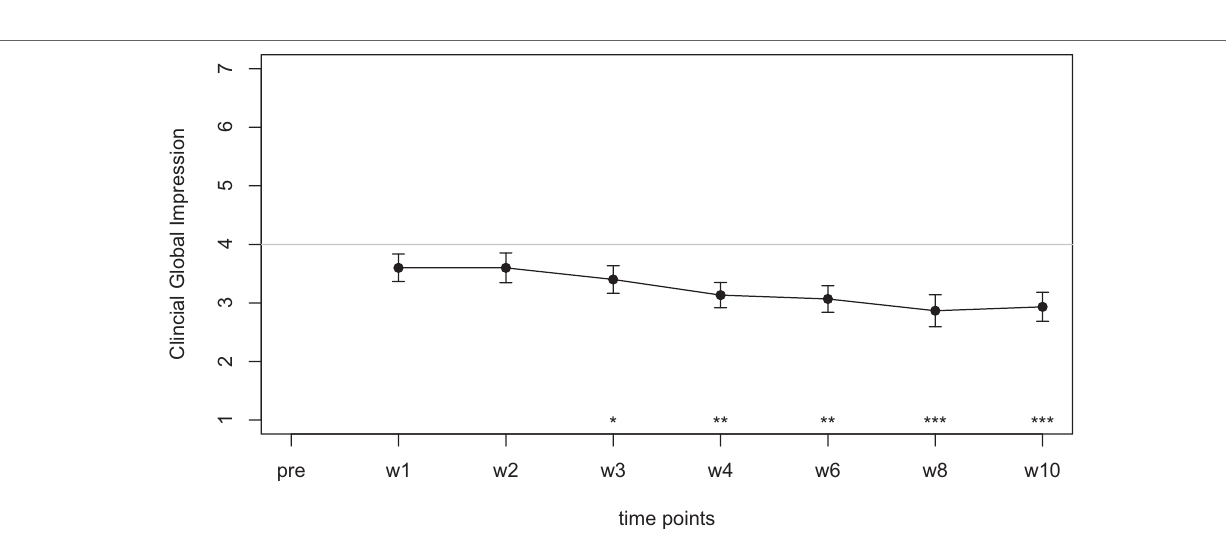
FigUre 2 | Average scores of the Clinical Global Impression scale (1–7). A rating of 4 on this scale indicates “no change.” Smaller numbers indicate an improvement of clinical symptoms (1 = “very much better,” 2 = “much better,” 3 = “minimally better”).